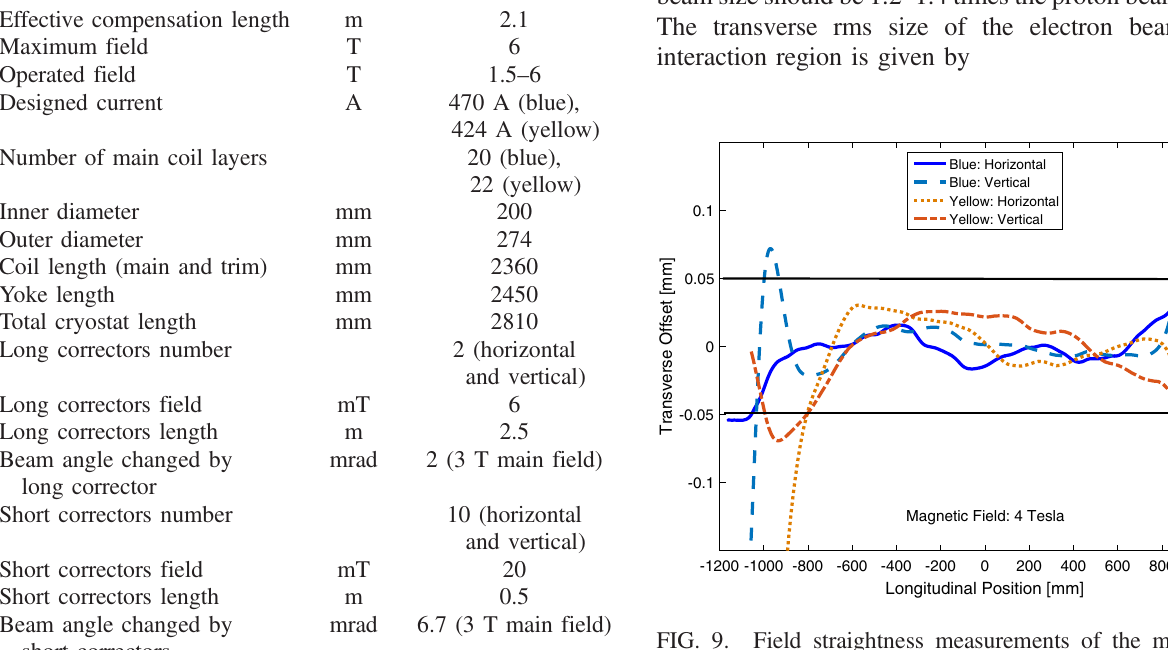
FIG. 9. Field straightness measurements of the main super- conducting